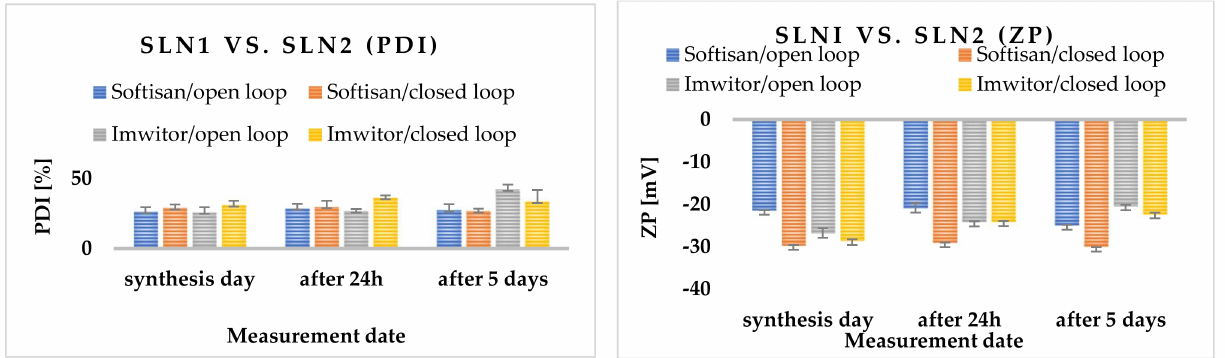
Figure 2. Comparison of polydispersity index (PDI) and zeta potential (ZP) of SLNs synthesized using lipids: Softisan ® 601 and Imwitor ® 900 and the surfactant Poloxamer 188 measured on the day of synthesis, and additionally 24 h and 5 days after the synthesis. The process of nanoparticle preparation was carried out in both open- and closed-loop systems under 300 bar pressure in three